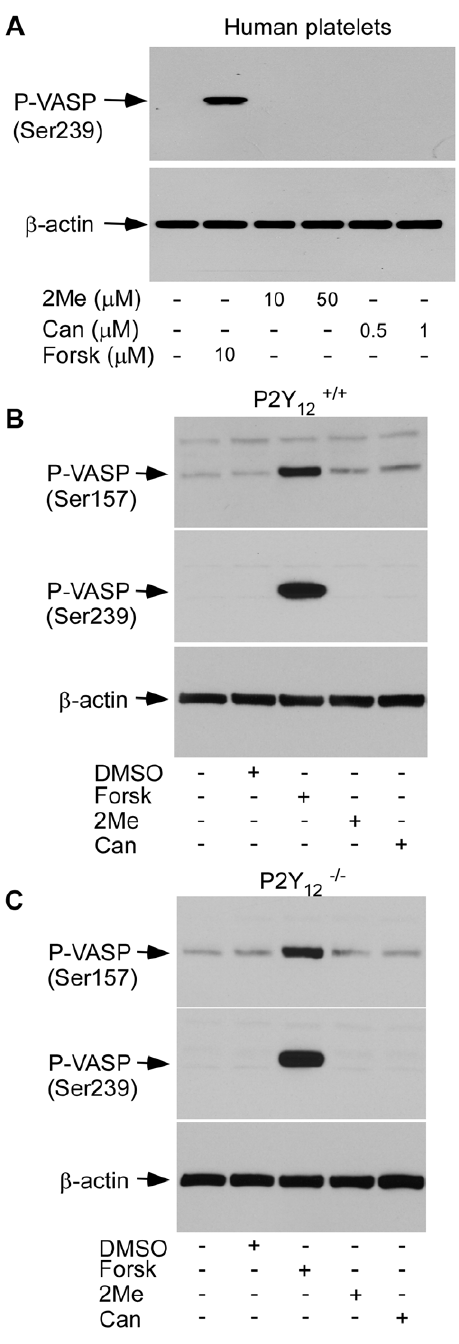
Figure 3. 2MeSAMP and Cangrelor failed to stimulate VASP phosphorylation in platelets. (A) Washed human platelets were incubated with 2MeSAMP (2Me), Cangrelor (Can), or forskolin (Forsk) at 37 u C for 5 min. The reactions were stopped by adding equal volume of 2 6 SDS sample buffer. Phosphorylation of VASP was detected by Western blotting with mouse monoclonal antibodies specifically recognizing the phosphorylated VASP residues Ser 239 . (B–C) Washed platelets from wild-type (B) or P2Y 12 deficient mice (C) were pre- incubated with DMSO, forskolin (10 m M), 2MeSAMP (10 m M), or Cangrelor (1 m M) for 5 min. Reactions were stopped by adding equal volume of 2 6 SDS sample buffer. Phosphorylation of VASP was detected by Western blotting with mouse monoclonal antibodies specifically recognizing the phosphorylated VASP residues Ser 157 or Ser 239 .